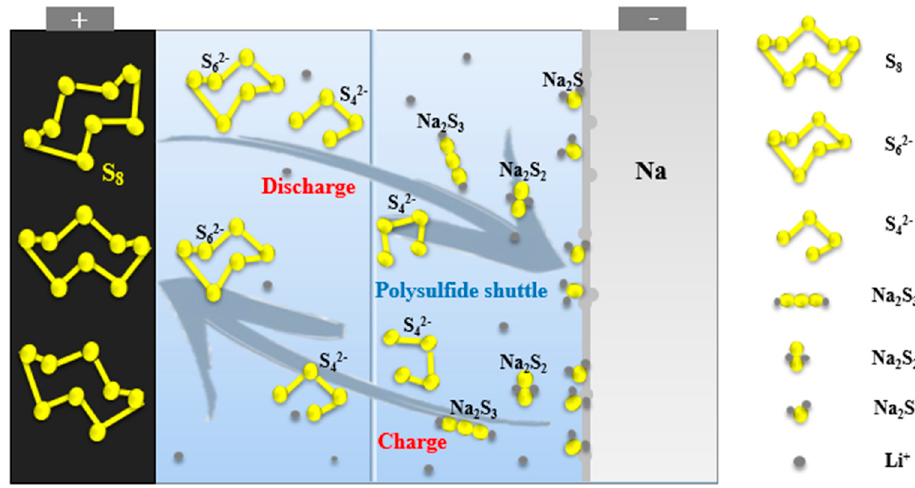
Figure 2. Schematic diagram of working mechanism and shuttle effect of sodium sulfur battery.